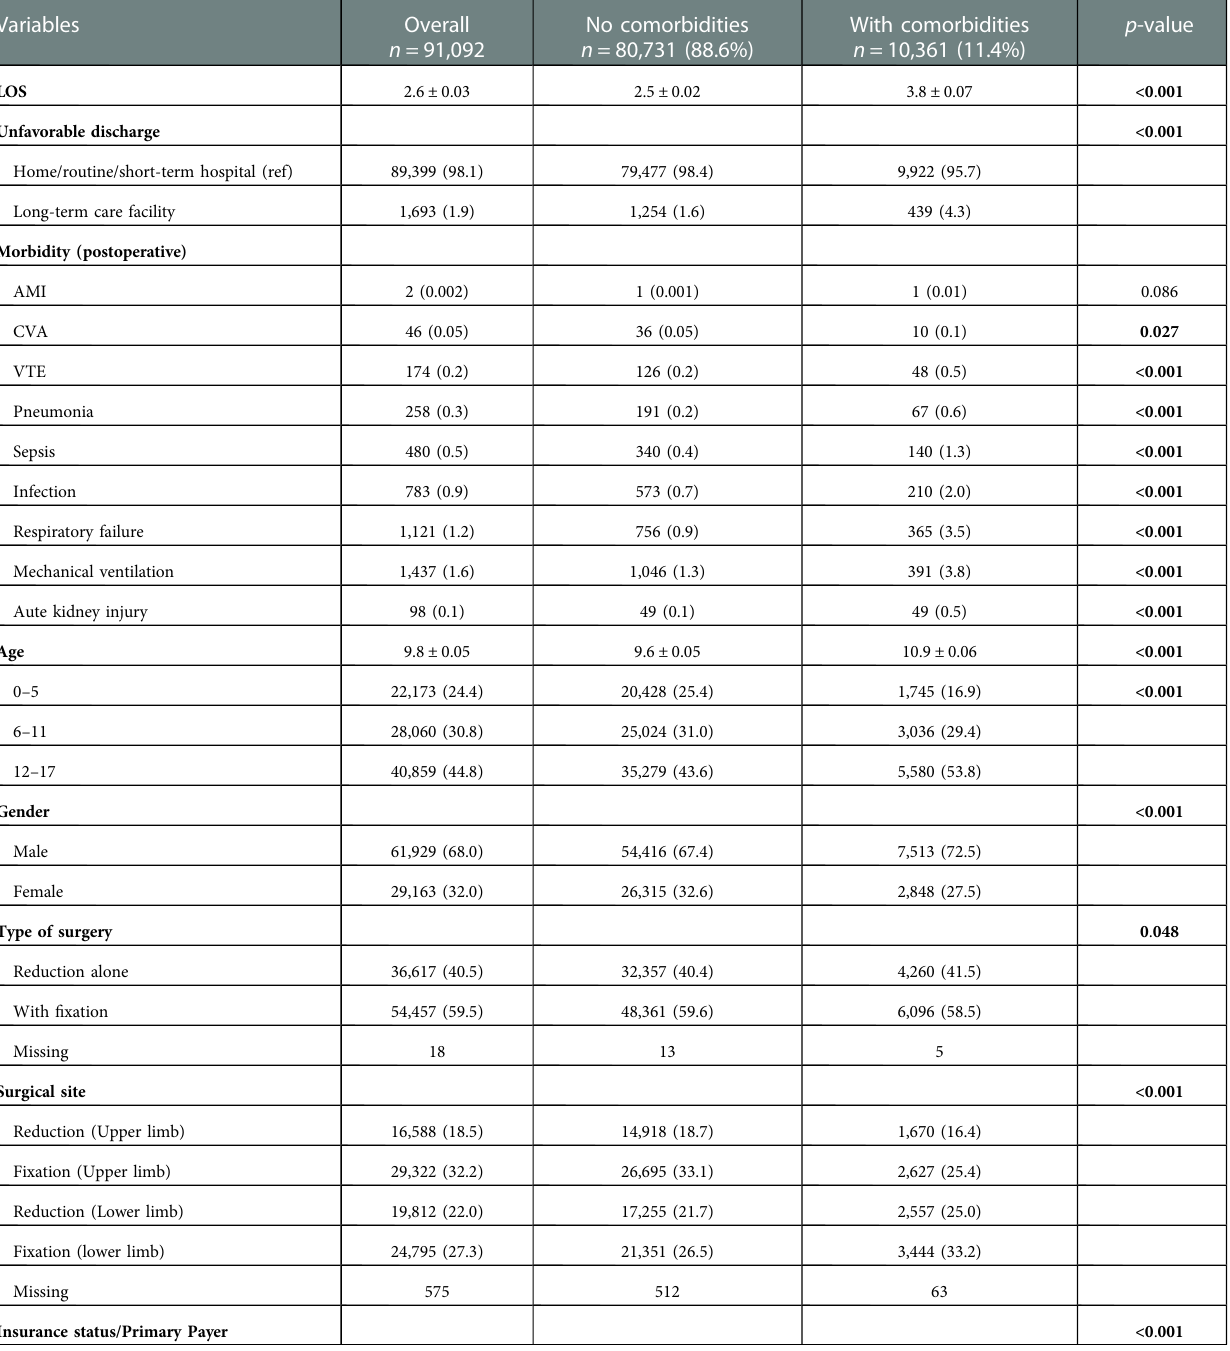
TABLE 1 Demographic and clinical characteristics of the study population.